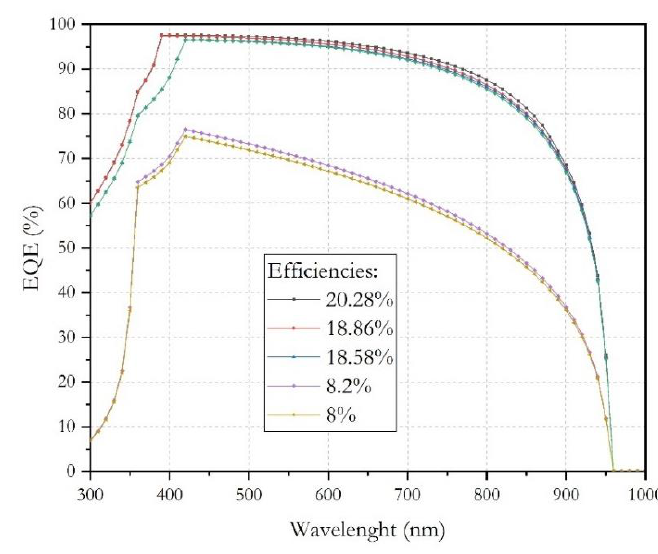
Figure 6. The external quantum efficiency of the PSC .